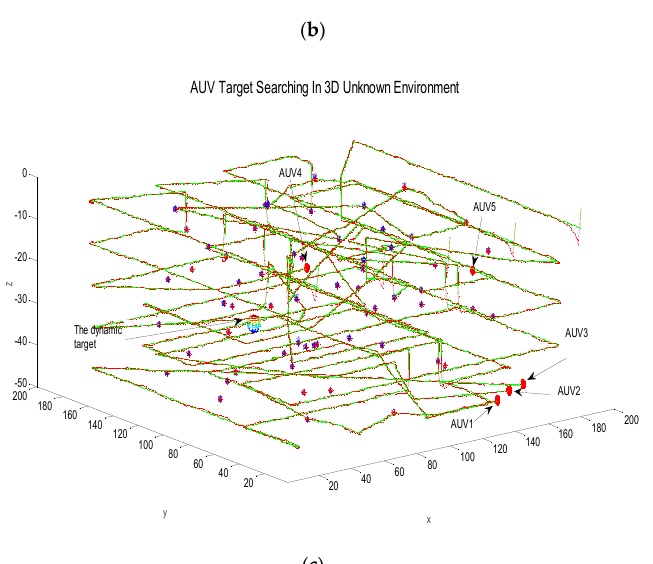
Figure 7. Random dynamic target search of the AUVs. ( a ) Initial state; ( b ) Search process with static targets and a random dynamic target; ( c ) AUV’s last search results.